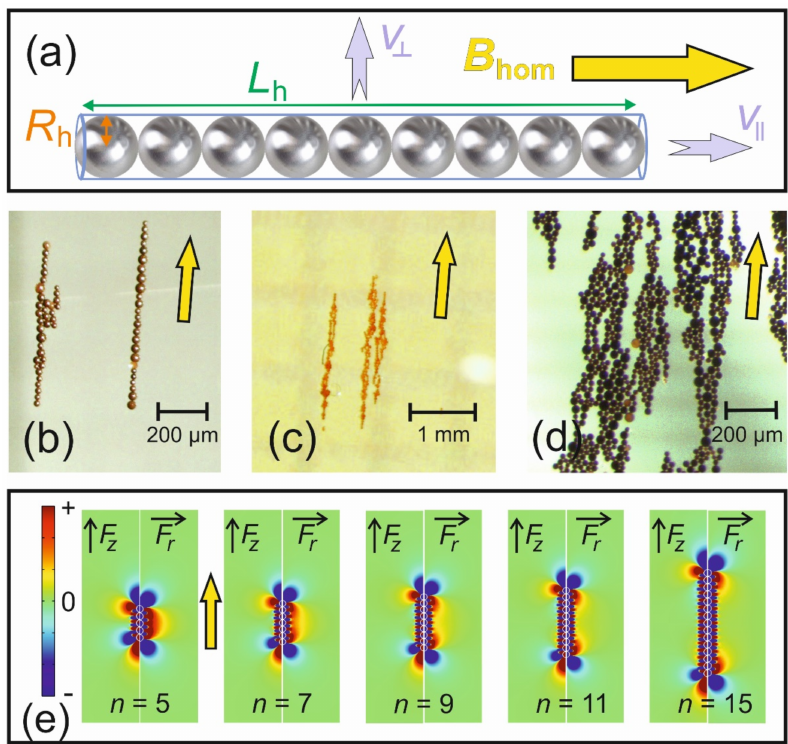
Figure 6. Behavior of superparamagnetic particles under magnetic guiding conditions: ( a ) Magne- (cid:42) B hom , the particles form long chains in the same direction. tized by the homogeneous magnetic field, Ideally they are mono-disperse spherical particles with a hydrodynamic radius, R h , and then n of them form a chain of length L h = n 2 R h . However, if they are moved, the velocity of the chain has two extremes of being moved either with v (cid:107) along the long axis or direction of the external field or perpendicular to this direction with v ⊥ . ( b – d ) Shows microscopic photographs of typical clusters of magnetite particles with an average diameter of 30 µ m. The yellow arrow indicates the direction (cid:42) B hom . ( b ) At low local concentration linear beaded chains (right) are typically formed. After a of certain length particles can also attach from the sides, forming spindle-shaped structures (left). ( c ) At higher concentrations such spindles dominate and separate from each other. ( d ) Such “carpet-like” structures are also observed at very high concentrations and at fluid surfaces. ( e ) FEM simulation (COMSOL 5.5) showing the magnetic force (Equation (1)) in cylindrical coordinates ( r , z ) around chains of n particles, which are all magnetized in the vertical (+ z ) direction. For a small number of particles; the “repulsive“ part (red) of the force dominates in radial direction. The particles must first overcome this force, to enter the attractive force minima (blue) closer to the chain. This repulsive force vanishes at the center for n ≥ 15. Therefore, particles aggregate at the sides of longer chains in a hexagonal pattern, causing the typical